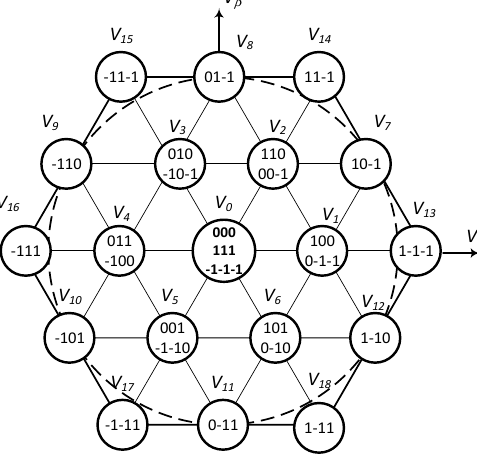
Figure 5. The space vector diagram of the 3-level T-Type NPC inverter stage.